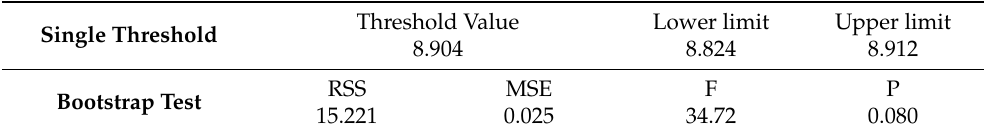
Table 8. Technical innovation level